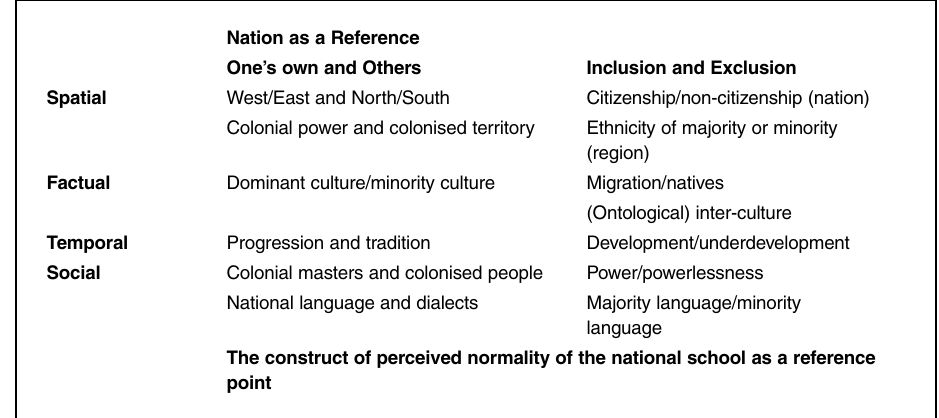
Table 3: Difference as a reference point to describe difference in the discourses of international comparative and intercultural education